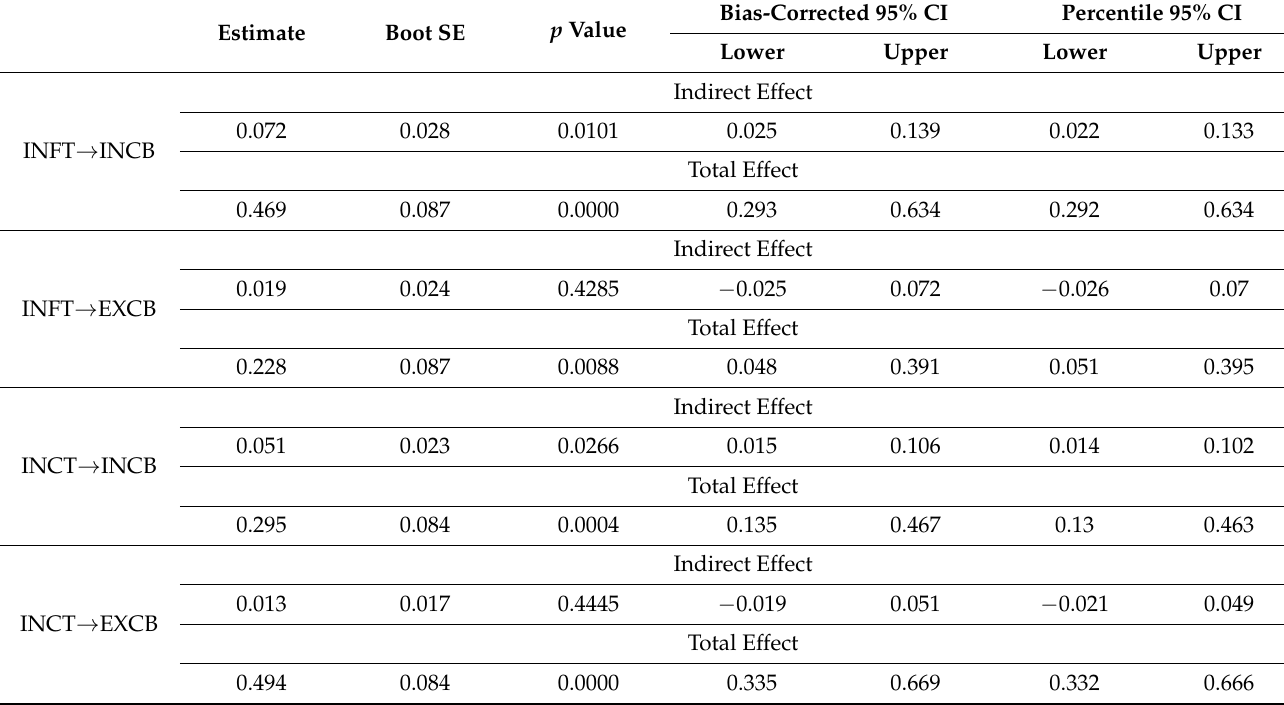
Table 5. Mediating effects of perceived